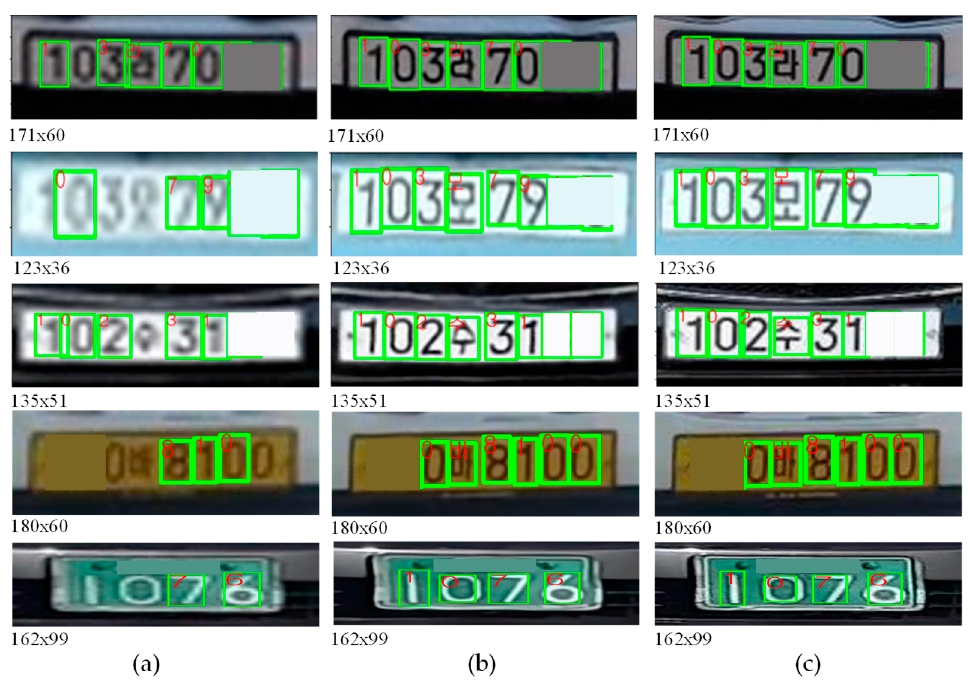
Figure 12. Examples of character recognition results. Recognition results on ( a ) bicubic results (3 × ), ( b ) proposed SR results (3 × ), and ( c ) HR images. Two characters were masked due to privacy policies.